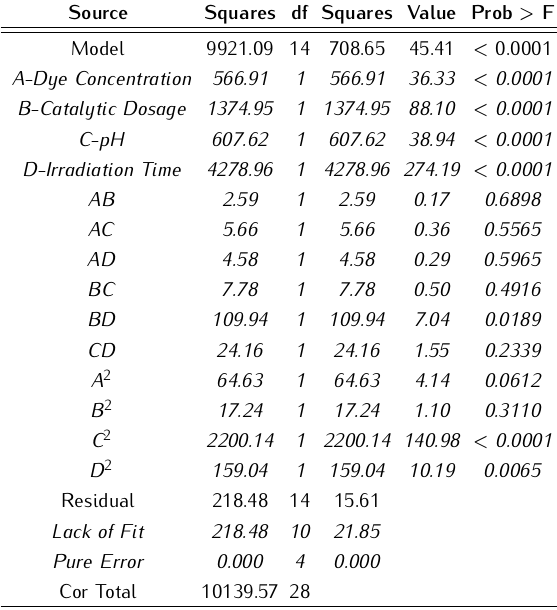
Table 4. ANOVA and lack-of-fit (LOF) test for response surface quadratic model of solar induced photo catalytic decolour- ization of dye effluent.